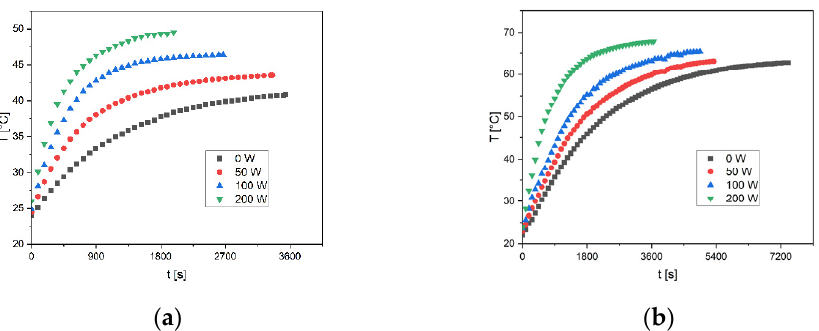
Figure 3. Temperature evolution of cubic sample. Applied US power: 0, 50, 100, 200 W. Air temperature: ( a ) 40 °C; ( b ) 60 °C.